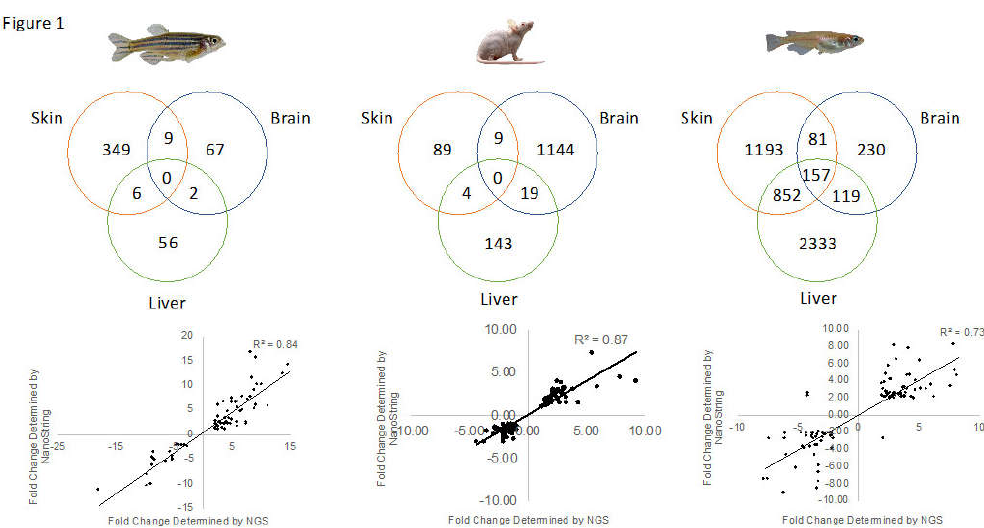
Figure 1. Following FL exposure, modulated genes compared to sham-treated samples were converted into HUGO IDs and imported into IPA. The mapped IPA genes from each organ tested (skin, brain, and liver) were compared using Venny (top row). Gene expression was verified using NanoString nCounter assay, and comparing fold changes back to RNA-Seq determined fold changes for each model tested (bottom row). In zebrafish (left) a total of 72 targets were tested using the nCounter assay on a custom zebrafish panel (Table S1). A Mouse PanCancer Immune Profiling Panel was used, and 103 gene targets were above background (center). In medaka (right), a total of 373 targets were tested using the nCounter assay on a custom medaka panel.